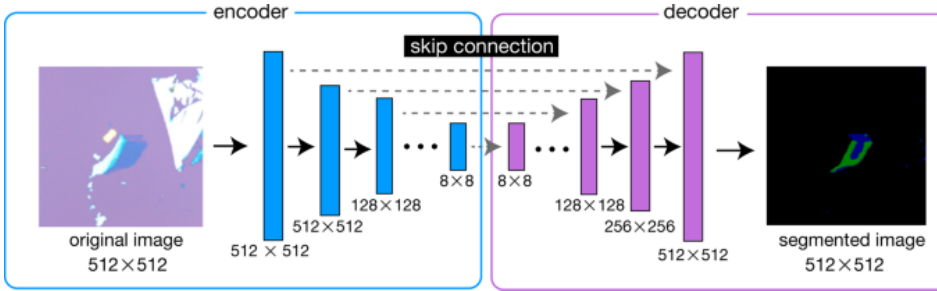
Figure 2. The final classifier showing the encoder decoder with skip connection.